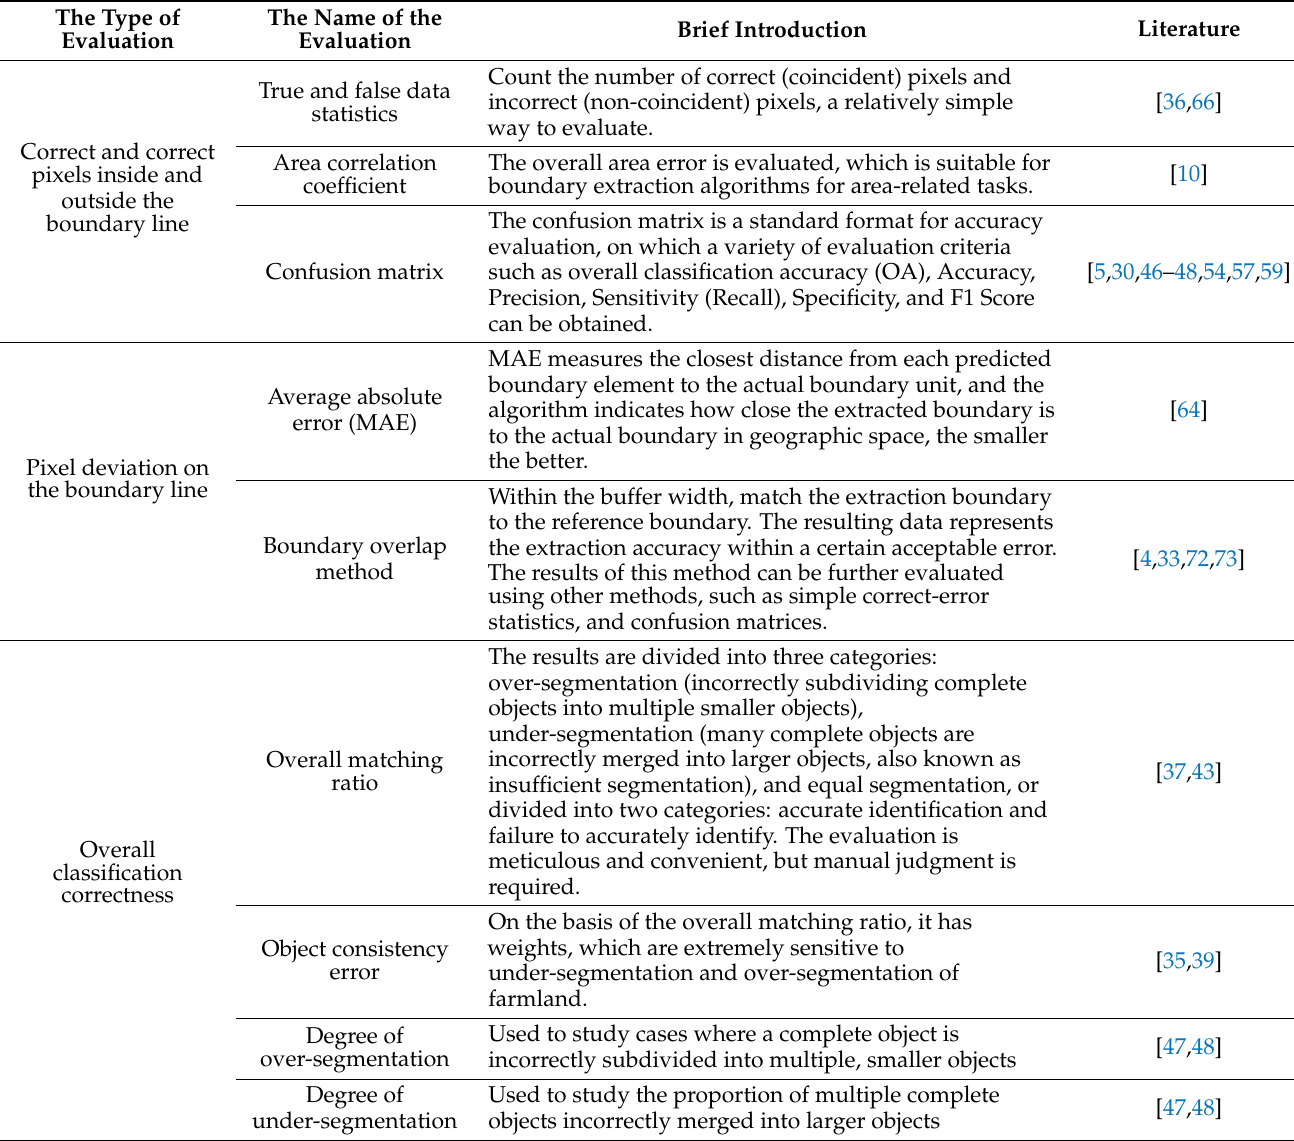
Table 5. Evaluations of core competencies.